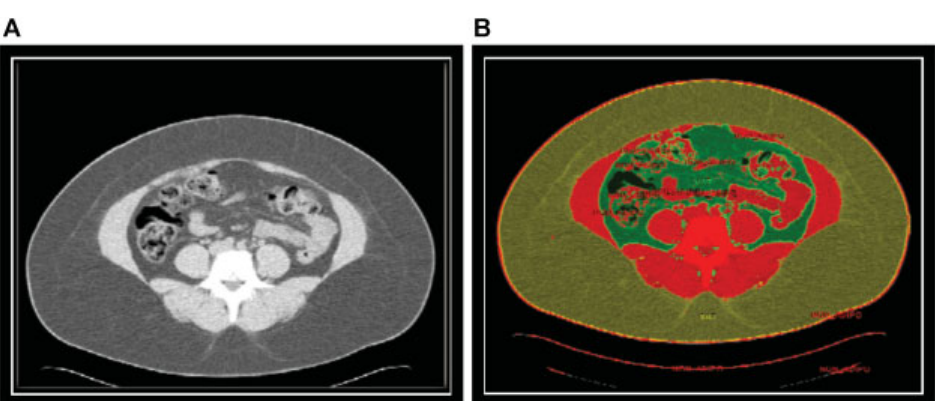
Fig. 1 Measurement of visceral and subcutaneous adipose tissue. ( A ) Screen capture from the region of interest module before segmenting. ( B ) Screen capture after segmenting VAT (green area) and SAT (yellow